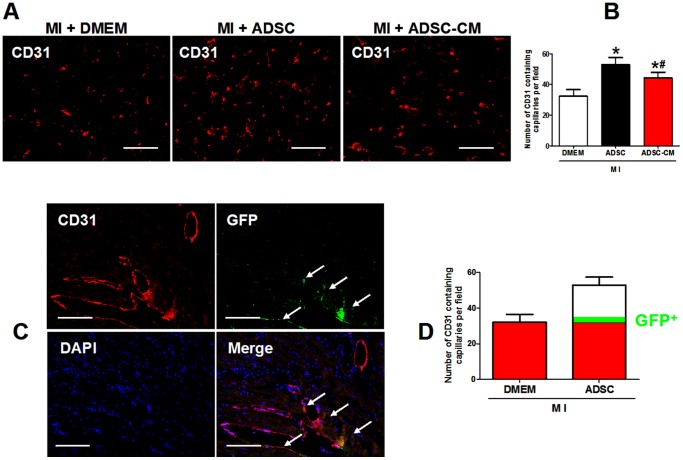
The contribution of ADSC differentiation to angiogenesis in post-MI heart.A-B: Representative figures and quantification of capillary density in infarct border zone at 4 weeks after ADSC transplantation analyzed by CD31 (endothelial cell marker) staining. *p<0.05 versus MI+DMEM; # p<0.05 versus MI+ADSC (N = 7). C: Representative figures of immunostaining GFP, CD31 and DAPI in the infarted hearts 4 weeks after ADSC transplantation. Arrows indicate GFP+/CD31+ capillaries, suggesting newly formed capillaries derived from transplanted ADSCs. Scale bars represent 50 µm. D: Quantification of the number of ADSC derived capillaries relative to overall increases in capillary density. In the diagram, GFP+ capillaries take about 9% of the increased capillary density compared to control (MI+DMEM). N = 6.